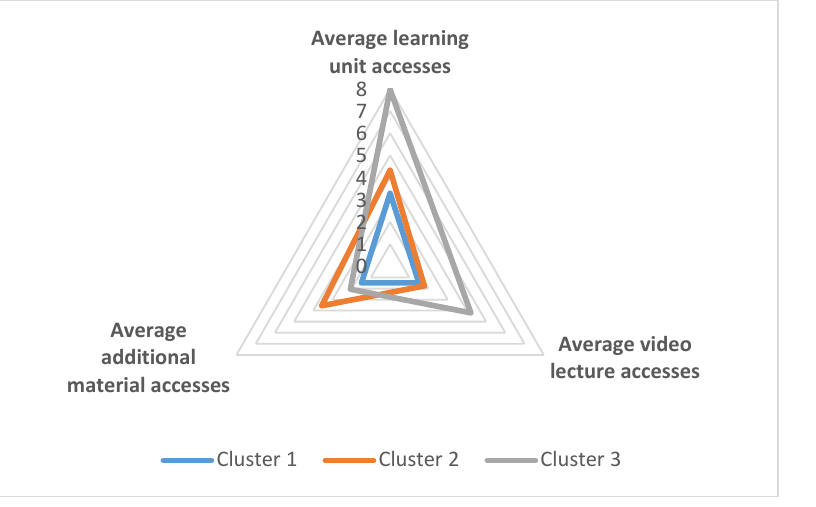
Figure 4 . Patterns of use of the flexibility of re-accesses to learning resources. Analysis of the order in which the students accessed the learning units is presented in Figure 5. The heat maps display, per course, the portion of students who accessed each learning unit during each